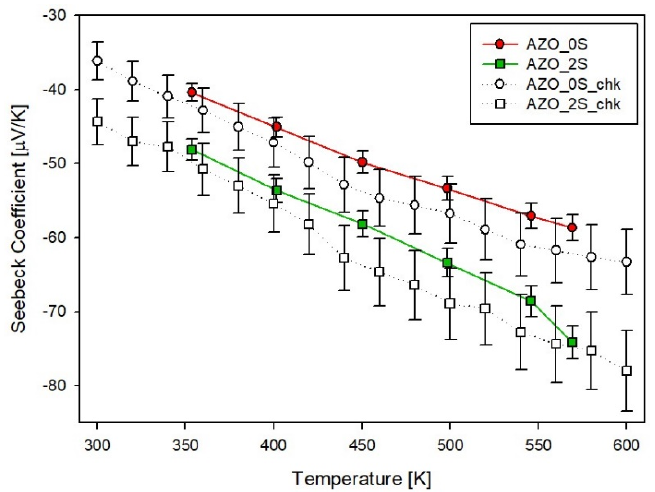
Figure C2. Seebeck coefficient plotted vs. temperature of AZO_0S and AZO_2S obtained with two different setups. Filled symbols are the same as those reported in the plots in the main text, while the open symbols “chk” were obtained with another device.